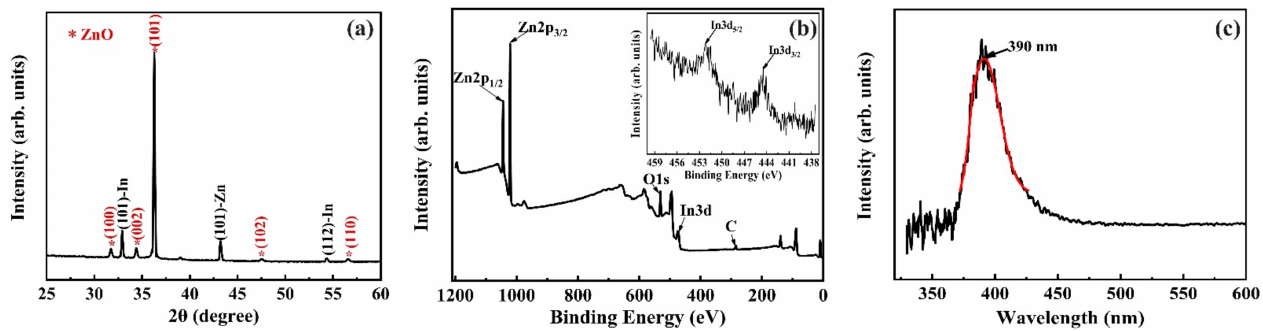
Figure 3. Characterization of ZnO nanowires with indium doping. ( a ) XRD pattern, ( b ) XPS spectrum, inset detail of XPS for In 3d enlarged peaks, ( c ) room-temperature PL spectrum of a single In-doped ZnO